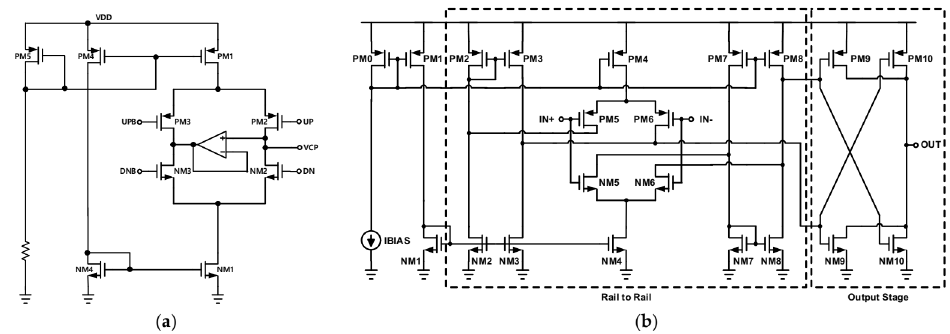
Figure 5. ( a ) Schematic of conventional Charge Pump based operational amplifier. ( b ) Rail to Rail